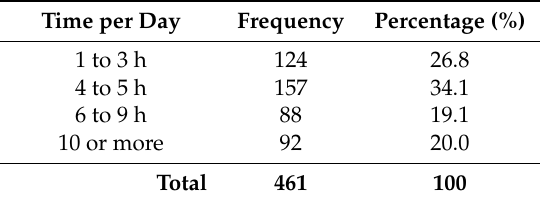
Table 4. Time per day devoted to smartphone use.